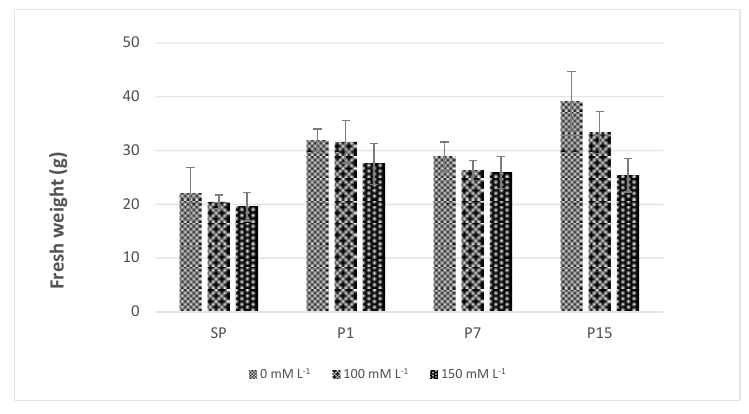
Fig. 1 The effect of salinity and inoculation of Pseudomonas strains (P1, P7, P15) versus a control (SP) on fresh weight of Vicia faba plants.